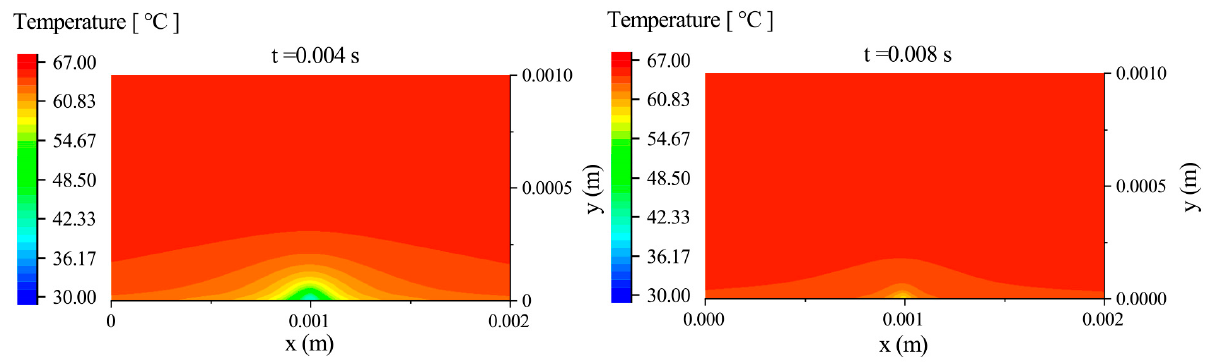
Figure 7. Distribution of temperature around the water-based ink droplet at different times.